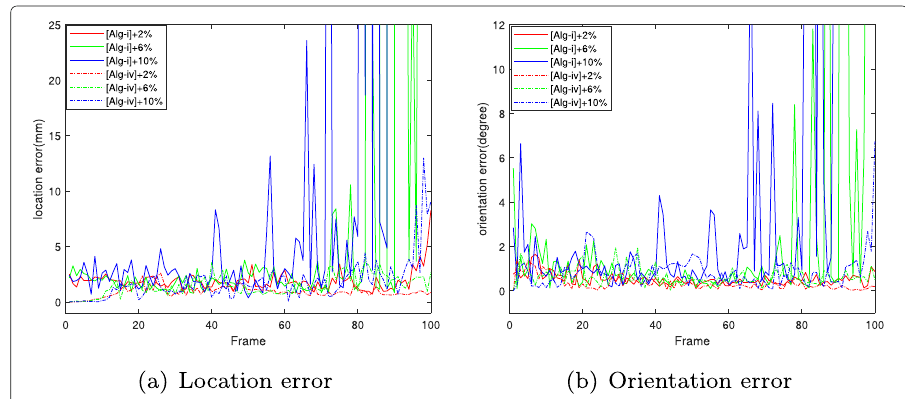
Fig. 7 Comparison of the estimation errors of the circular pose parameters of the two algorithms under the scenario with zero-mean additive